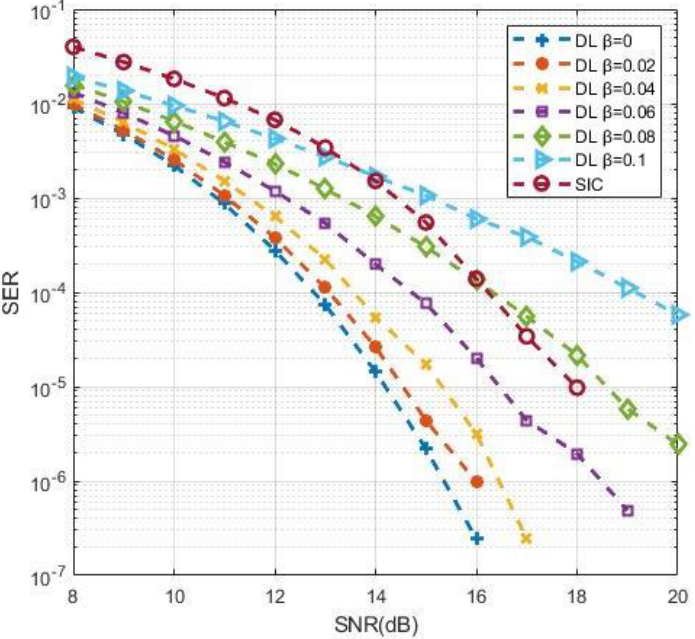
Figure 14. SER performance with channel estimation